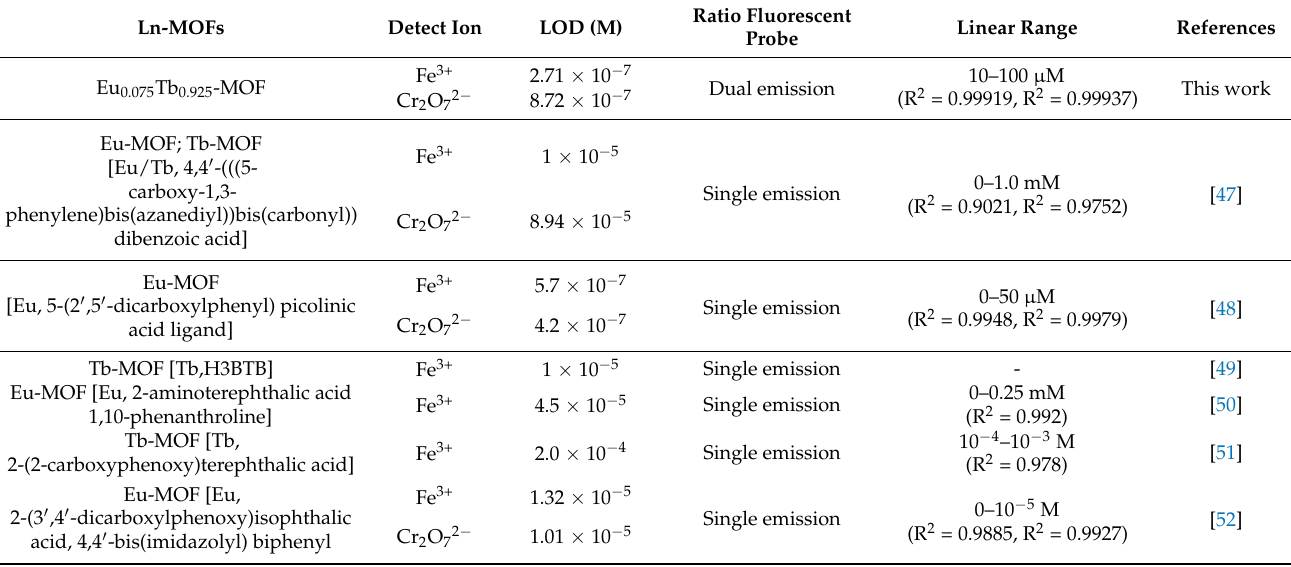
Table 2. Comparison of the reported methods for Fe 3+ and Cr 2 O 72 − using